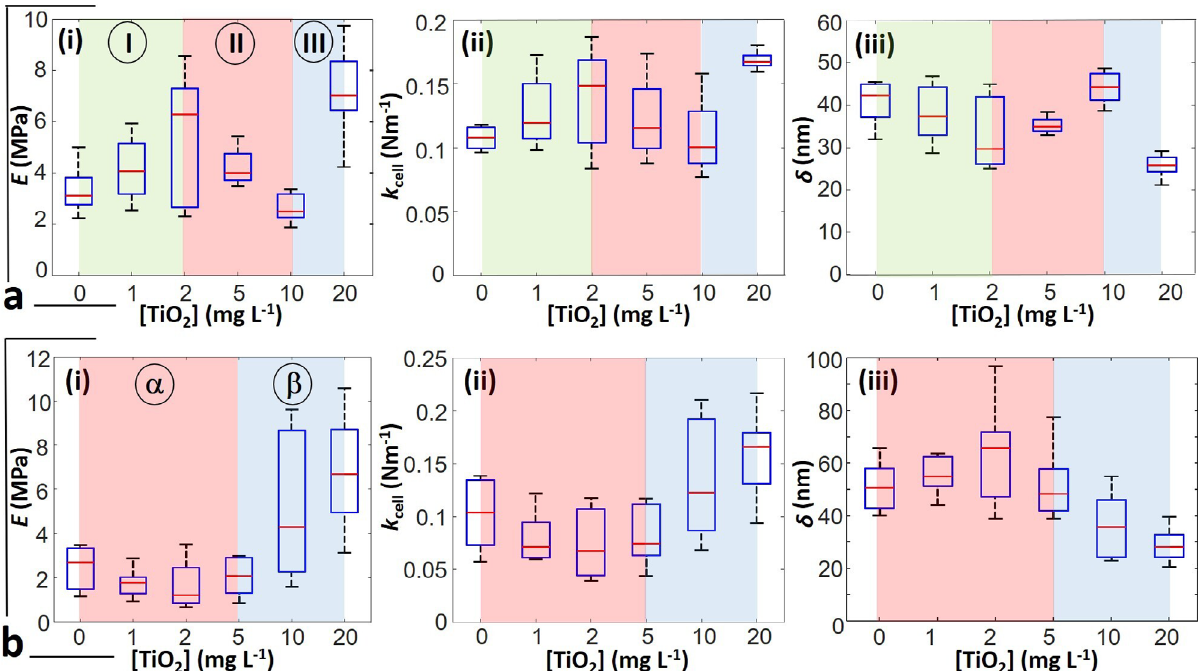
Fig. 8 Nanomechanical properties of JW3606 (hep + ), unlike those of JW3596 (hep − ), vary non-monotonously with increasing TiO 2 NP concentration. Dependence of (i) Young modulus E , (ii) cell stiffness k cell , and (iii) indentation δ as a function TiO 2 NP concentration for a JW3606 (hep + ) and b JW3596 (hep − ) after 20 h exposure to TiO 2 NPs. Data correspond to distributions of the median values of E , k cell , and δ represented in the form of box plots and derived for each condition from measurements on n = 8 cells issued from different colonies or different cell cultures. Regimes I, II, III, α and β refer to distinct modes of action of TiO 2 NPs on JW3606 (hep + ) and JW3596 (hep − ), see details in the text. The red lines are the median of the plotted distributions. Statistical signi fi cance testing and p -values are provided in the Supplementary Information.